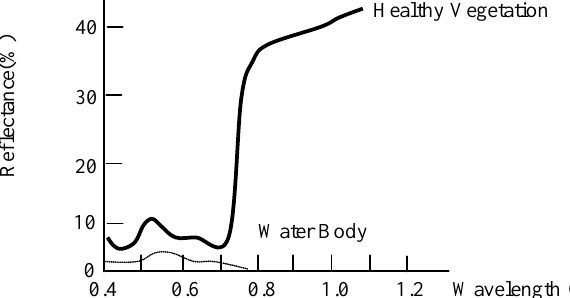
Figure 1. Spectral reflectance of vegetation and water body (Jensen, 2007)